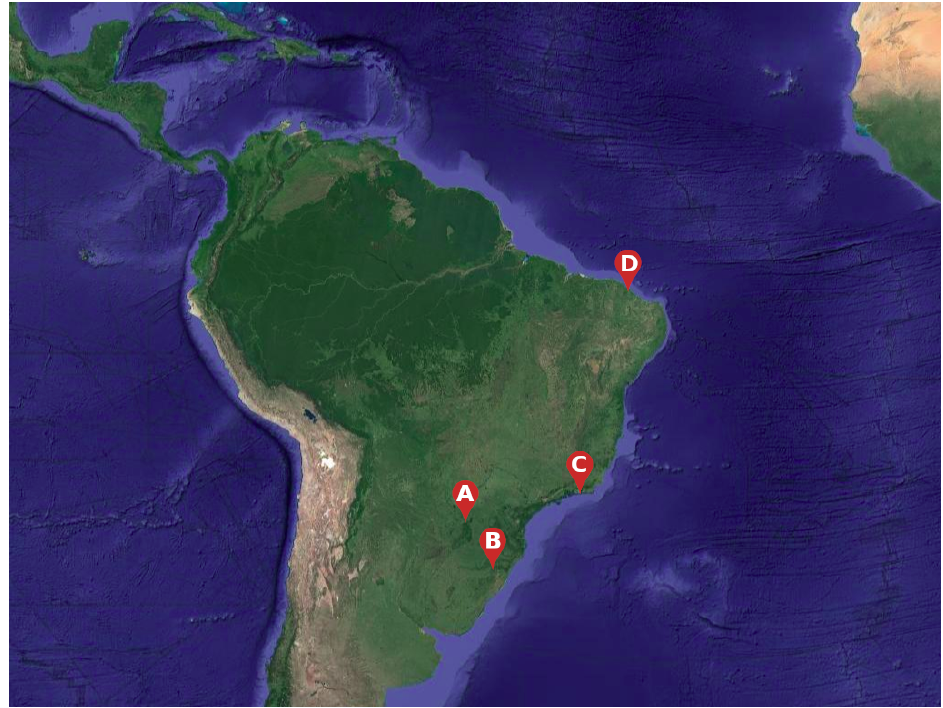
Figure 2. Brazilian municipalities as noted in a South America satellite view: (A) Foz do Iguaçu; (B) Porto Alegre; (C) Rio de Janeiro; (D) Fortaleza